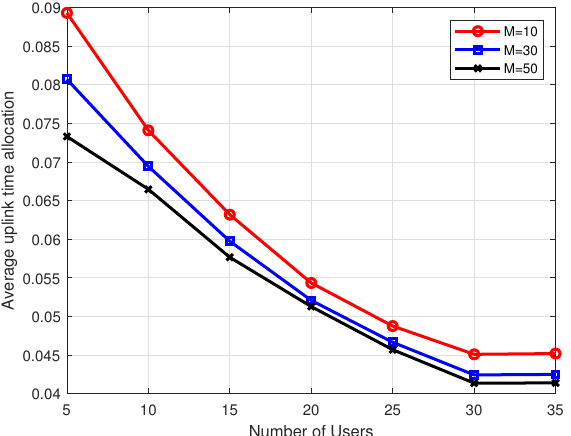
Figure 5. Average uplink time allocation versus the number of